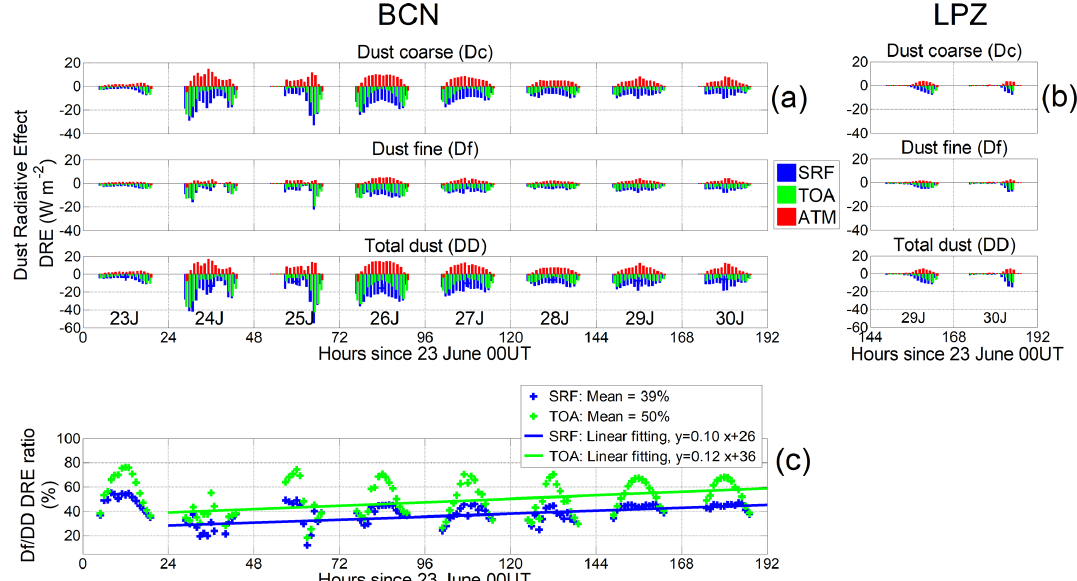
Figure 7. Instantaneous dust direct radiative effects (DRE) on the surface (SRF) (blue), TOA (green), and in the atmosphere (red) in (a) BCN and (b) LPZ. (c) Fine-to-total (Df / DD) ratio of the instantaneous dust DRE on the surface (SRF) and at the TOA in BCN; the best linear fit has been calculated between 24 and 30 June (i.e. discarding 23 June) (both mean values and linear fittings are included in the legend). The absolute increase in Df / DD DRE ratio on SRF (TOA) of + 0.10%h − 1 ( + 0.12) is equivalent to an increase of + 2.4%d − 1 ( + 2.9). UT stands for